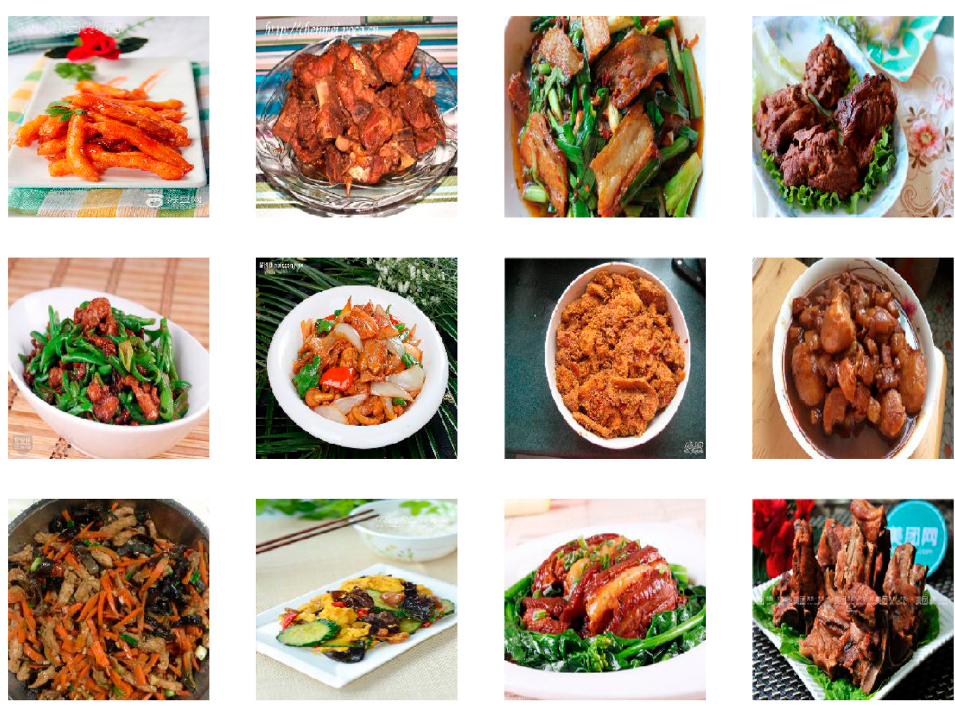
Figure 2. VIREO-Food172 Dataset samples.